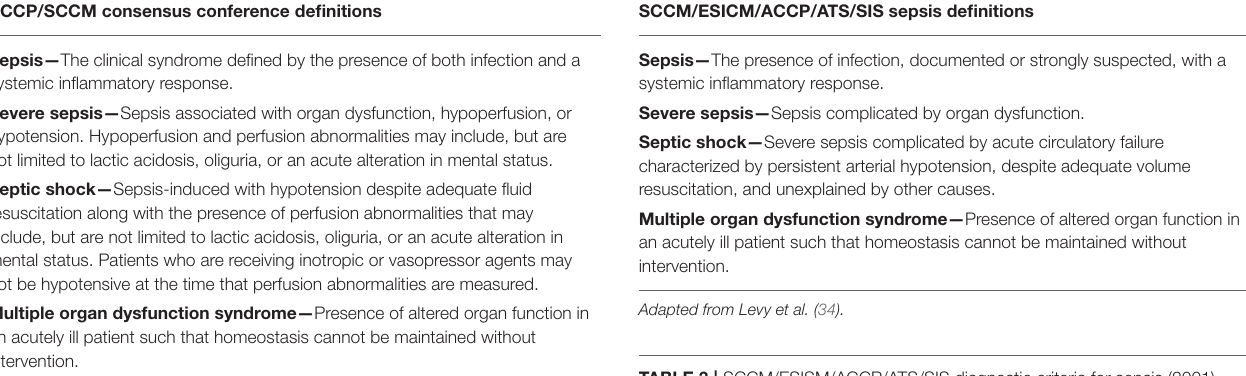
TABLE 3 | SCCM/ESISM/ACCP/ATS/SIS diagnostic criteria for sepsis (2001). SCCM/ESICM/ACCP/ATS/SIS Expanded diagnostic criteria for